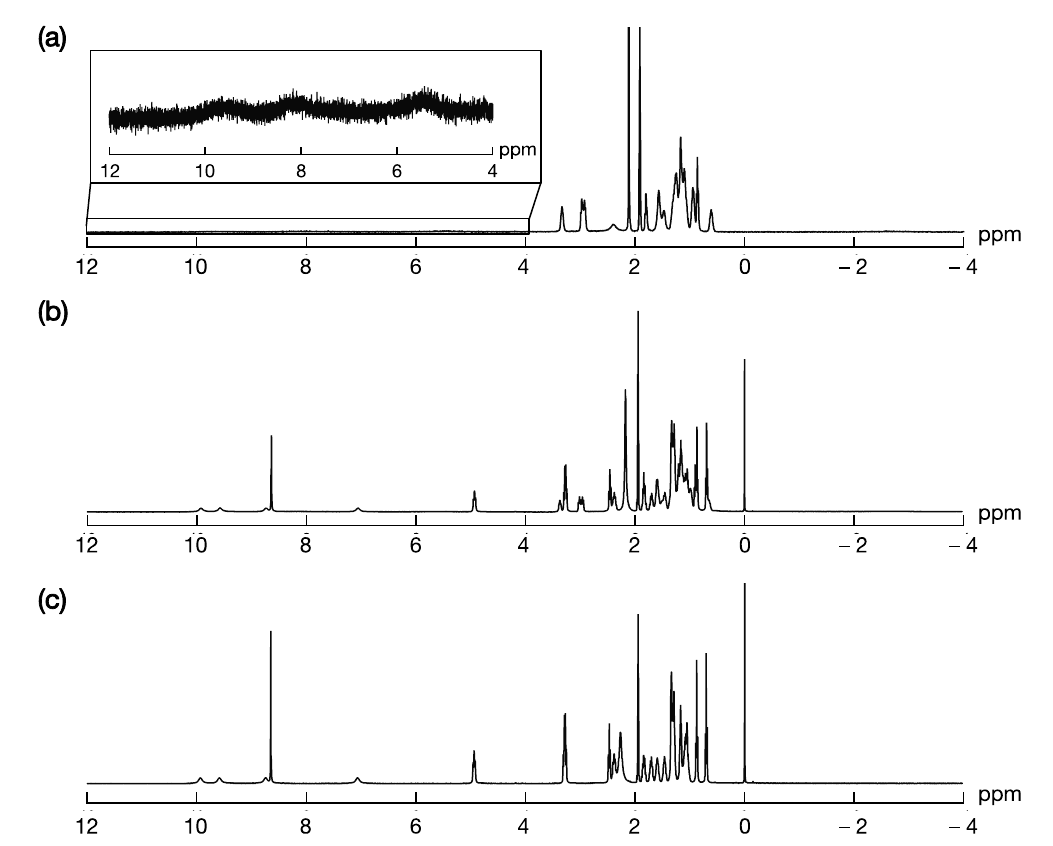
Figure 2. 1 H NMR titration of 1 red (2.5 mM in CD 3 CN) with NO + ·PF 6 − . 1 H NMR spectra of ( a ) 1 red , ( b ) a mixture of 1 red and 0.5 equiv. of NO + ·PF 6 − , and ( c ) a mixture of 1 red and 1.0 equiv. of NO + ·PF 6 − .